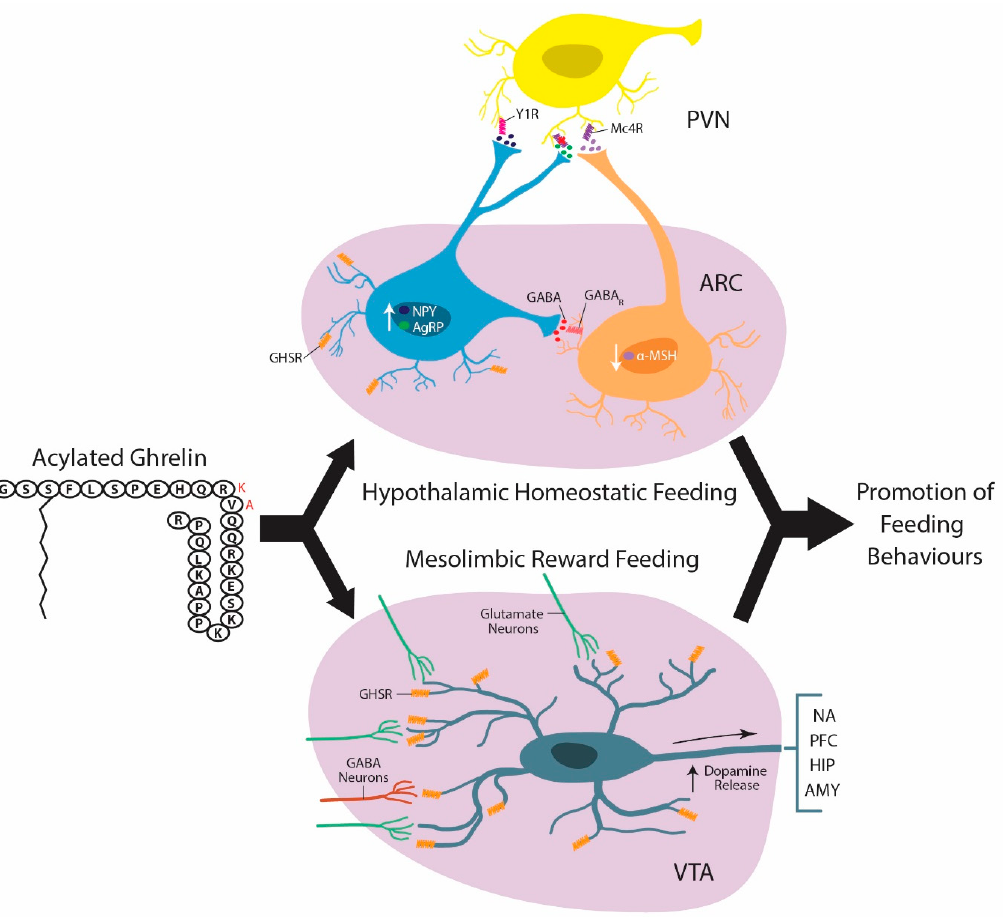
Figure 2. Over simplified illustration depicting the two main brain regions where acylated ghrelin (human ghrelin is black amino acid sequence and red letter substitution is rat) is proposed to target to initate neurocircuits that promote feeding behaviours: the arcuate nucleus (ARC) of the hypothalamus (HYP) and the ventral tegmental area (VTA). Within the ARC, ghrelin stimulates neuropeptide Y/agouti-related peptide (NPY/AGRP) neurons by binding growth hormone secretagogue receptors (GHSRs) on their surface. Once activated theses neurons produce and release γ -aminobutyric acid (GABA) which inhibits anorectic proopiomelanocortin (POMC) neurons,decreasing the release of the anorectic peptide α -melanocyte-stimulating hormone ( α -MSH). This effectively reduces the quantity of α -MSH capable of binding to satiety promoting melanocortin 4 receptors (Mc4Rs). Concurrently, activated NPY/AGRP neurons increase their production and secretion of orexigenic peptides NPY and AGRP. NPY binds to neuropeptide Y receptor type 1 (Y1R) and AGRP antagonizes the binding of α -MSH at Mc4Rs. Together the reduction in anorectic peptide and enhancement of orexigenic ones work to reduce the activity of second order anorexigenic neurons in the paraventricular nucleus (PVN) to promote homeostatic feeding behaviours. Similarly, ghrelin also stimulates VTA dopamine (DA) neurons increasing the frequency and probability of DA release from their projections in the nucleus accumbens (NA), prefrontal cortex (PFC), hippocampus (HIP), and amygdala (AMY) to encourage mesolimbic reward feeding. Ghrelin activates these VTA dopamine neurons both directly by binding to GHSR receptors located on their surface and indirectly by increasing the ratio of excitatory to inhibitory synapses contacting them.